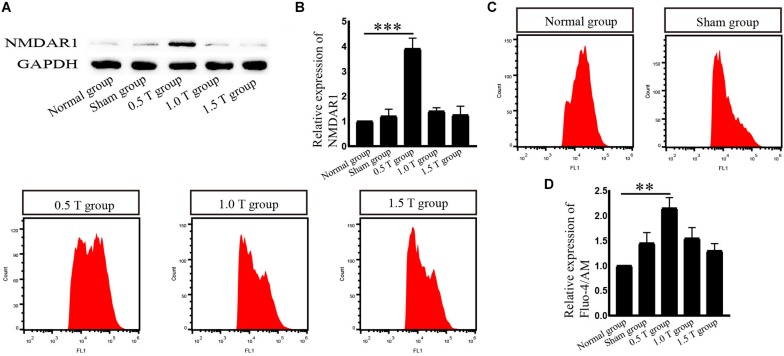
Repetitive transcranial magnetic stimulation (rTMS) mediates the levels of NMDAR1 and intracellular calcium (Ca2+) in bone mesenchymal stromal cells (BMSCs). (A) NMDAR1 assessed by western blotting. (B) Quantification of western blotting for NMDAR1. Data were analyzed with a one-way ANOVA followed by Dunnett’s multiple comparison test. ∗∗∗P < 0.001, n = 3. Error bars = SD. The value of NMDAR in the 0.5 T group was 3.900 ± 0.424. (C) Detection of Ca2+ levels by Fura-4/AM after rTMS. (D) Quantitative fluorescence intensity of Ca2+ levels. Data were analyzed with a one-way ANOVA followed by Dunnett’s multiple comparison test. ∗∗P < 0.01, n = 3. Error bars = SD. The value of Ca2+ in the 0.5 T group was 2.150 ± 0.212.